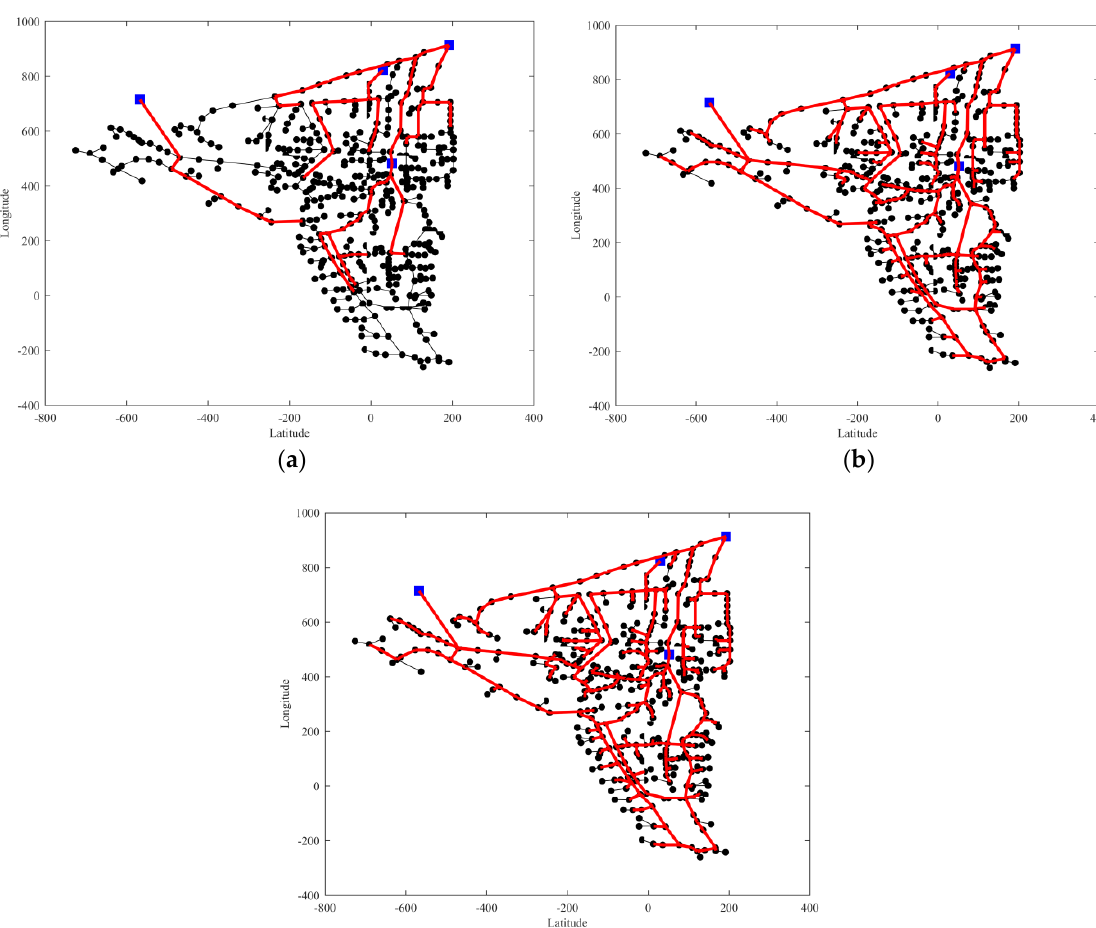
Figure 13. Scenarios for the TN size: ( a ) 20%; ( b ) 60%; and, ( c ) 90%; the red lines represent the TN and the blue squares the water sources.